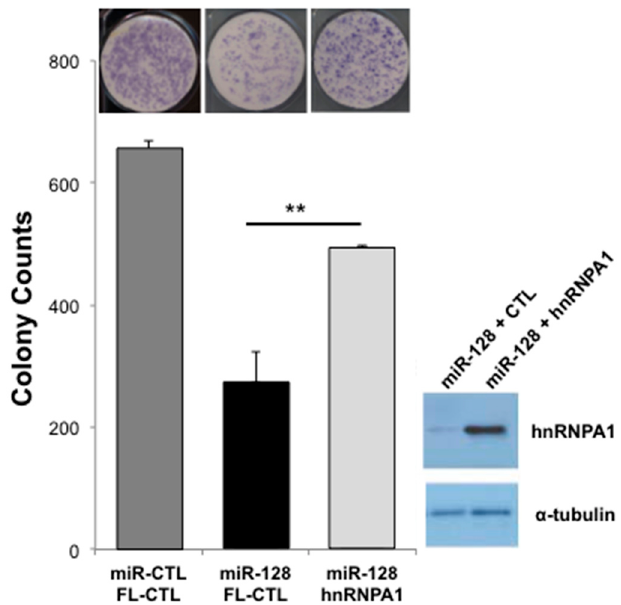
Figure 5. hnRNPA1 partly rescues miR-128-induced inhibition of de novo L1 retrotransposition. The functional importance of hnRNPA1 in miR-128-induced L1 repression was evaluated by colony formation assays using mutant L1 (miR-128 resistant) or RT deficient L1 (RT-dead L1) expression constructs in stable HeLa cell lines expressing either miR-control (miR-CTL) or miR-128 along with either a plasmid control (FL-CTL) or induced hnRNPA1 (hnRNPA1) ( n = 3 technical replicates, mean ± SD, ** p < 0.01). Western blot analysis was performed for hnRNPA1 and α -tubulin to validate increased levels of hnRNPA1 in miR-128-hnRNPA1 rescue HeLa cell lines (panel).